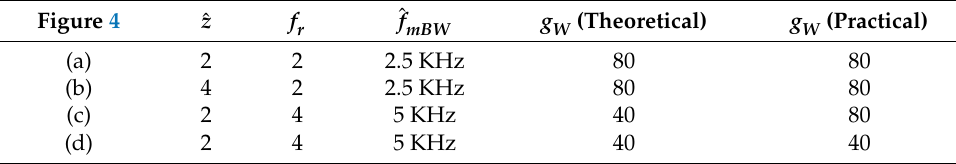
Table 1. Configuration of each parameter in Figure 4.